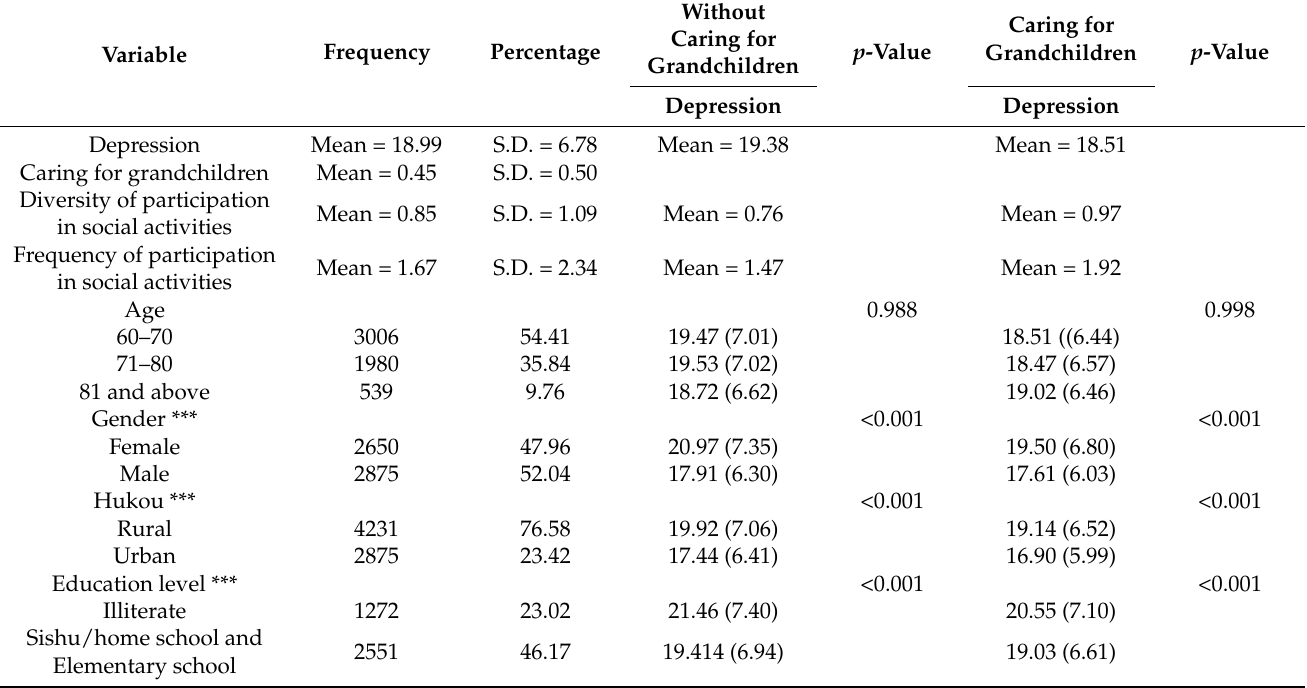
Table 2. Sample characteristics ( n =